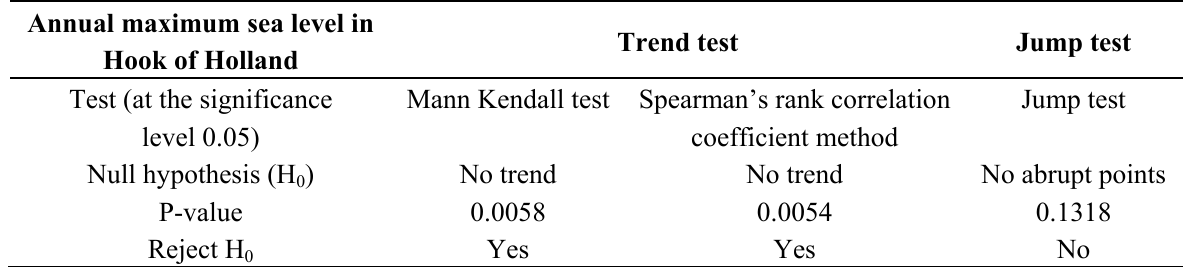
Table 2. Tests on the annual maximum sea level at Hook of Holland.